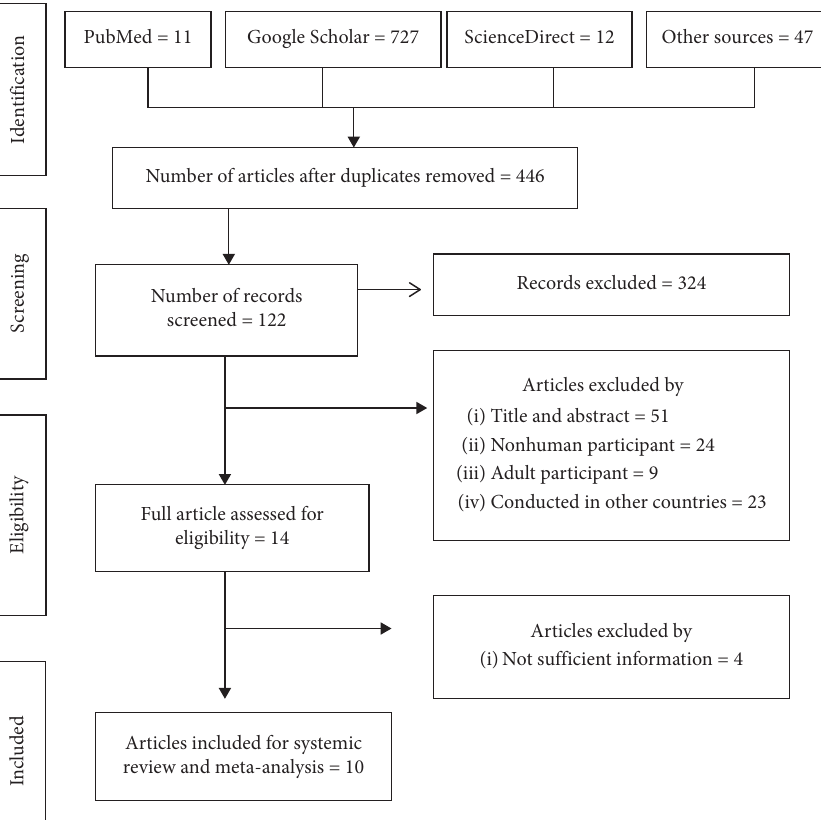
Figure 1: Flowchart of study selection for systematic review and meta-analysis of the prevalence of Escherichia coli in under-five children with diarrhea in Ethiopia. Table 1: Summary of selected studies reporting the prevalence of Escherichia coli in different parts of Ethiopia, from 1970 to 2019.